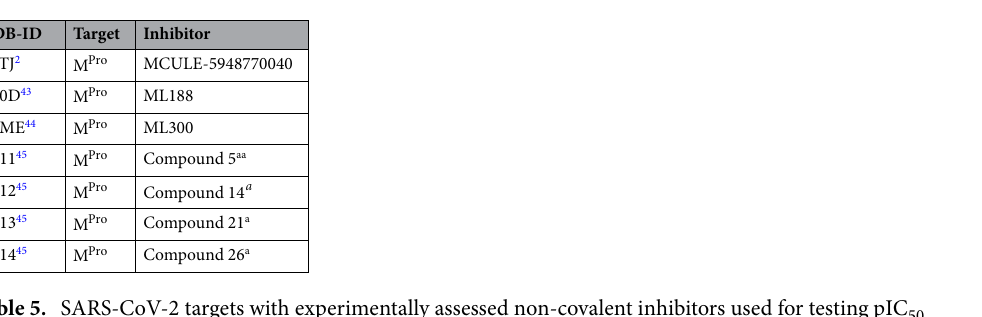
Table 5. SARS-CoV-2 targets with experimentally assessed non-covalent inhibitors used for testing pIC 50 models. a As defined by Zhang et al. 45 .